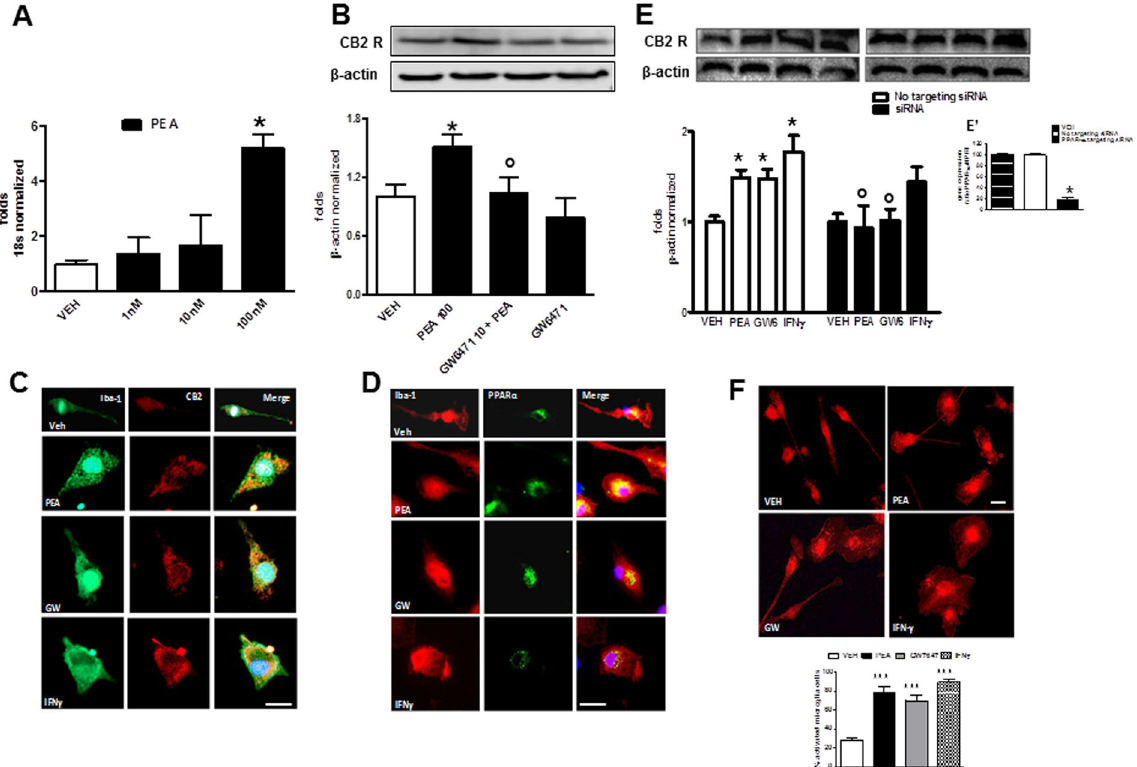
Figure 1. PEA induces CB2R expression via PPAR- α activation. ( A ) Real-time PCR analyses of CB2m-RNA in cultured microglia following incubation with PEA (1, 10 and 100 nM for 24 hours), using 18S as a loading control. Data are shown as mean ± SD (n = 6–8). * P < 0.05 compared to vehicle-treated cells. One way ANOVA, post-hoc Tukey’s. ( B ) Representative western blot image and related quantification showing the expression of CB2R in microglial cell lysates following incubation with vehicle, PEA (100 nM), GW6471 (10 µ M) + PEA, or GW6471 alone, using β -actin as a loading control. Data are shown as mean ± SD (n = 6–8). * P < 0.05 compared to vehicle-treated cells, °P < 0.05 compared to PEA-treated cells. One way ANOVA, post-hoc Tukey’s. (C ) CB2R expression (red) in Iba-1 labeled microglia (green) following incubation with vehicle, PEA (100 nM), GW7647 (1 µ M), IFN γ (300 U/ml). Scale bar = 25 μ m. ( D ) PPAR- α expression (green) in microglia cells (red) following incubation with vehicle, PEA (100 nM), GW7647 (1 µ M), IFN γ (300 U/ml). Scale bar = 25 μ m. ( E ) Representative western blot image and related quantification showing the expression of CB2R in microglial cell lysates incubated for 24 hours with vehicle, PEA (100 nM), GW7647 (1 µ M), IFN γ (300 U/ml), in presence of siRNA or non-targeting siRNA. Data are shown as mean ± SD (n = 6). * P < 0.05 compared to vehicle, °P < 0.05 compared to relative control within non-targeting siRNA group. One way ANOVA, post-hoc Tukey’s. ( E’ ) Real-time PCR analyses of PPAR- α /HPRT ratio in PPAR- α silencing (siRNA) or non-targeting siRNA conditions, compared with vehicle. Data are shown as means ± SD (n = 6). * P < 0.05, One way ANOVA, post- hoc Tukey’s. (F) Representative staining and related quantification of microglia cells in Iba-1 labeled microglia incubated for 24 hours with PEA (100 nM), GW7647 (1 µ M) or IFN γ (300 U/ml), compared with vehicle-treated cells. Morphological evaluations measured as a percentage of activated cells over the total cell number. Data are shown as mean ± SEM (n = 6). *** Indicates statistically significant values (P < 0.0001) vs. vehicle-treated cells. One way ANOVA, post-hoc Tukey’s. Full-length gels are showed in Supplementary Figs S6 and